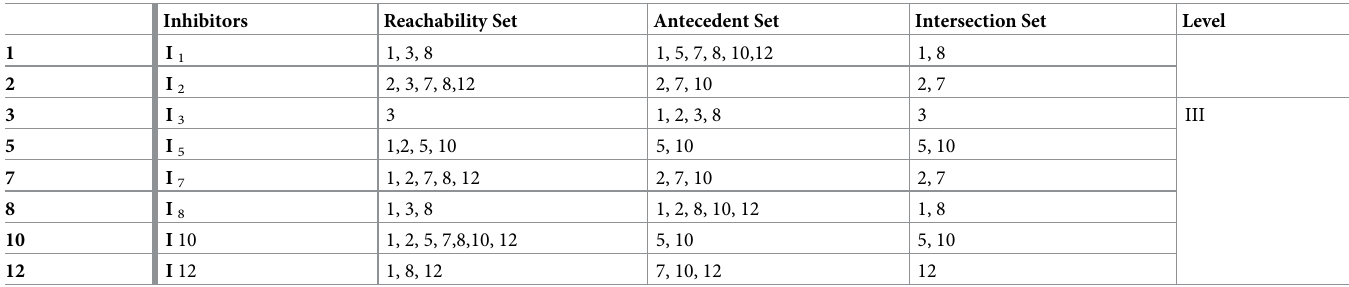
Table 9. Level partitioning iteration-3.